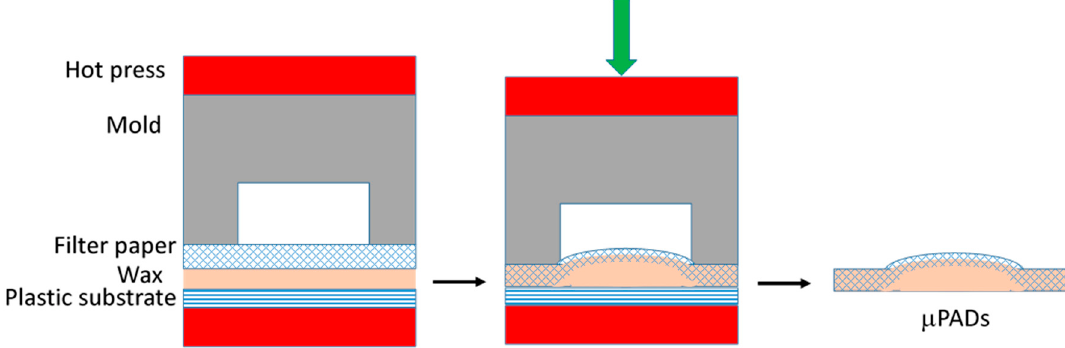
Figure 1. Schematics of one-step hot microembossing process (not in scale).